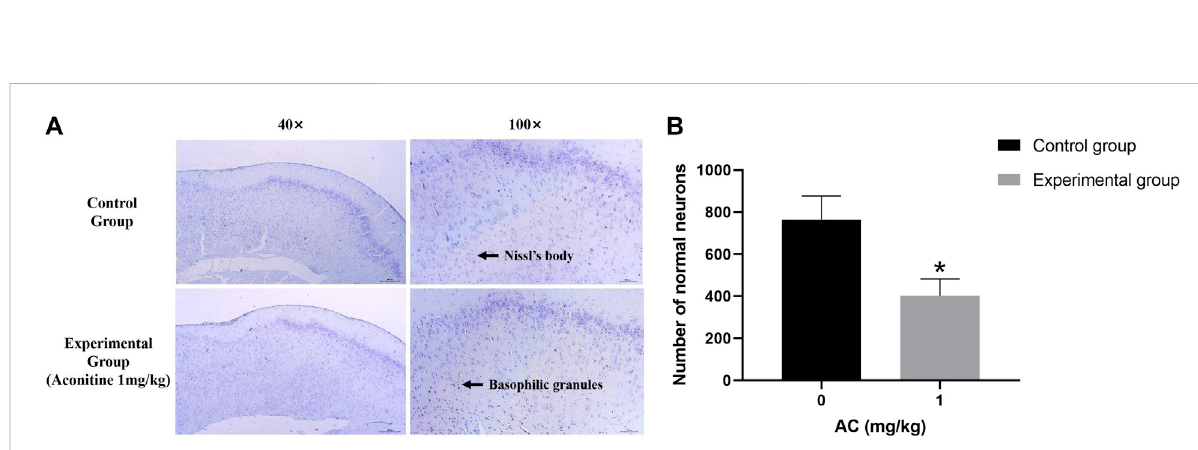
FIGURE 9 Treatment of aconitine for 7 days reduced the activity of hippocampus neurons. (A) Representative images magni fi ed 40 and 100 times in hippocampus. (B) Quantitatively analyzed the number of Nissl ’ s bodies in control and experimental group (×100). (* p < 0.05 versus control group).